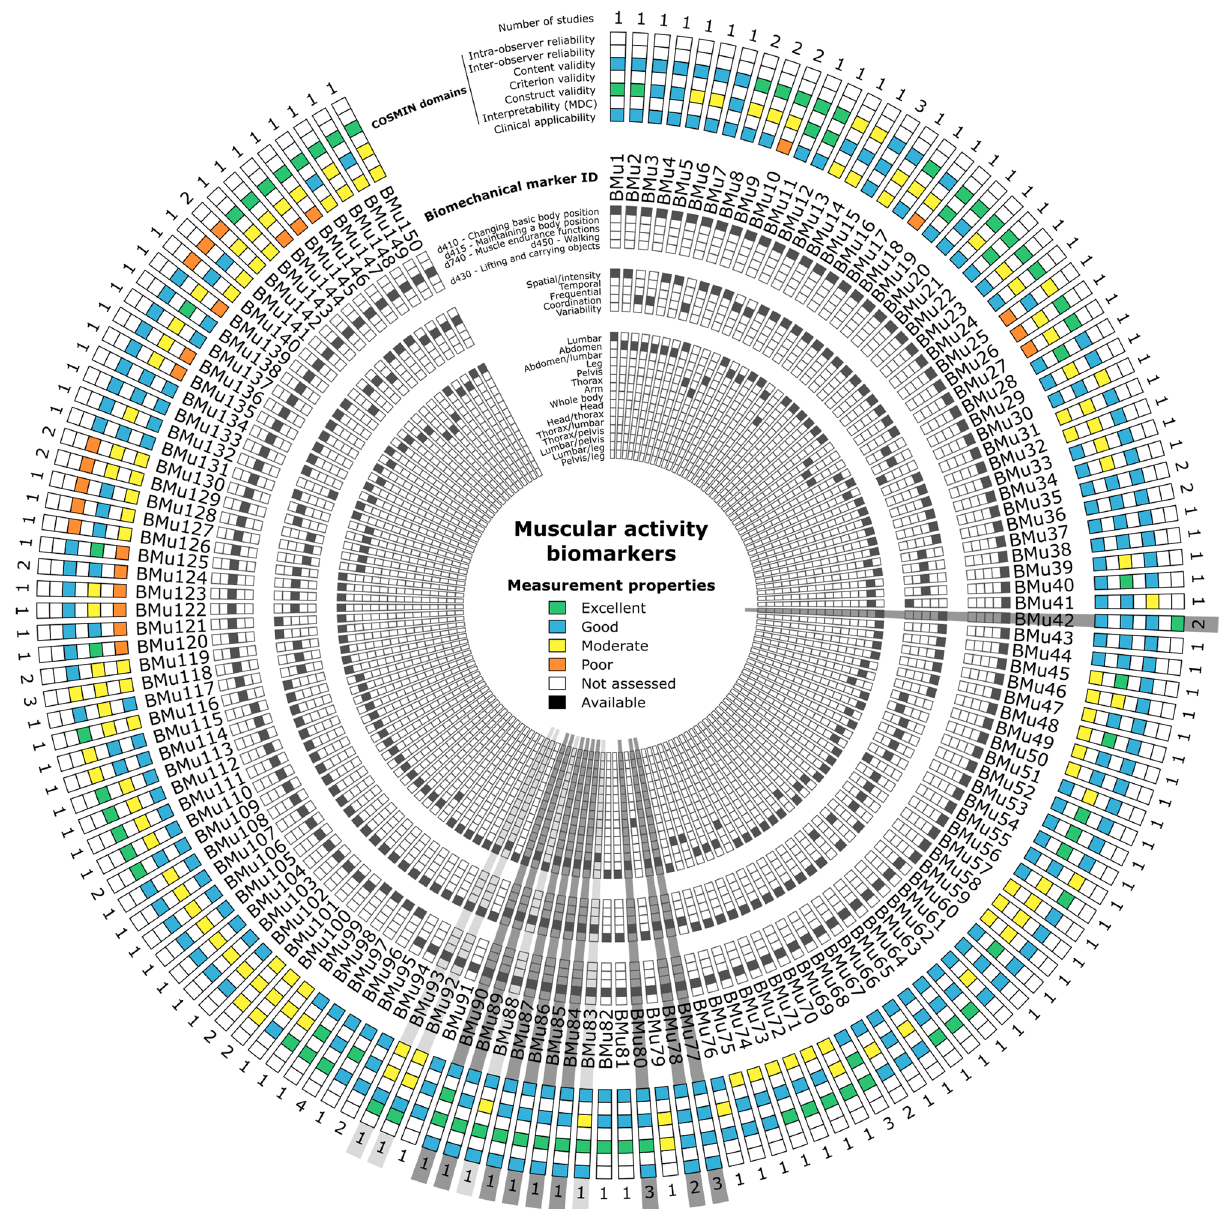
Figure 5. Circos plot 55 synthesising the main characteristics and measurement properties of each muscular activity biomarker. See Table 4 for measurement properties rating. Biomarkers are underlined in grey when at least 3 COSMIN items have been assessed, and dark grey when all these items reached at least a good level. Biomarker characteristics have been sorted by